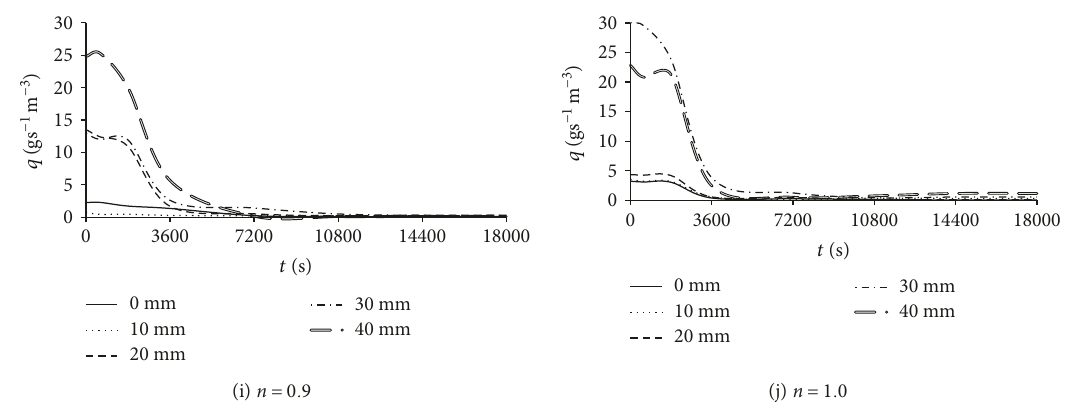
Figure 5: Time-varying characteristics of the mass-loss rate in broken mudstone samples.